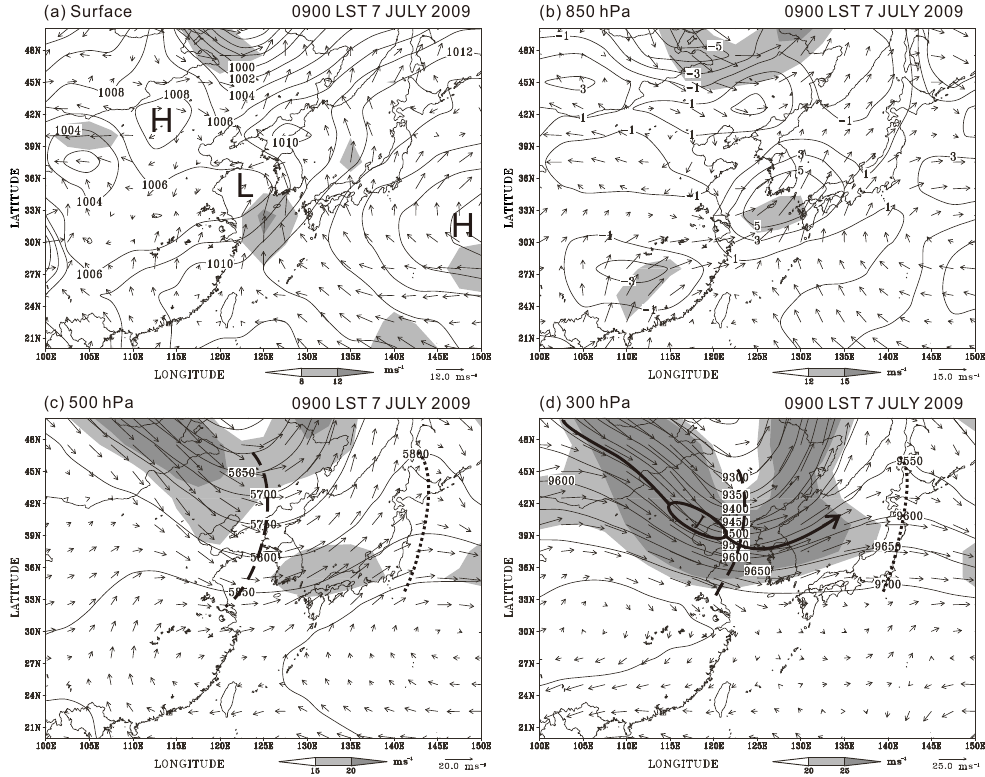
Figure 4. NCEP–NCAR reanalysis of (a) horizontal wind vectors (ms − 1 , speed also shaded) and pressure (hPa, contours) at mean sea level, (b) horizontal wind vectors (ms − 1 , shaded), temperature advection (10 − 2 Ks − 1 , contours) at 850hPa, and (c) – (d) horizontal wind vectors (ms − 1 , shaded), and geopotential height (gpm, contour every 50gpm) at (c) 500 and (d) 300hPa for 09:00LST 7 July 2009. Thick dashed (dotted) lines in (c) – (d) depict the trough (ridge), and the core and axis of the upper-level jet (ULJ) are also marked in (d) .